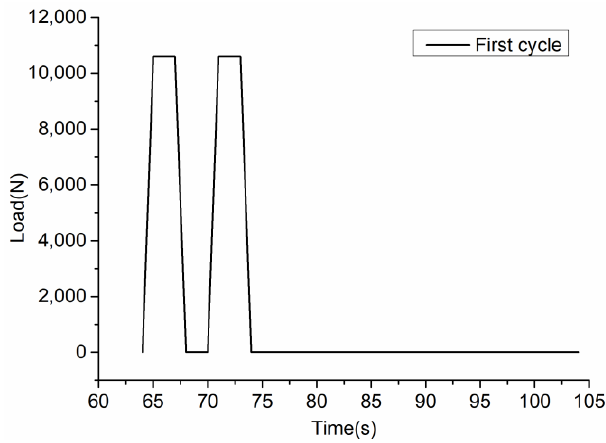
Figure 3. Loading curve and repeating cycles.